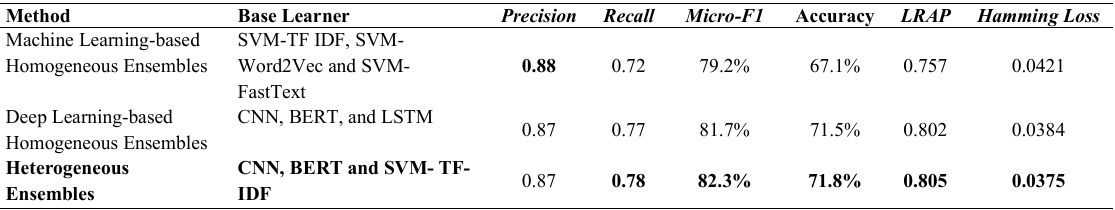
TABLE 3 T HE RESULT OF H ETEROGENEOUS E NSEMBLES